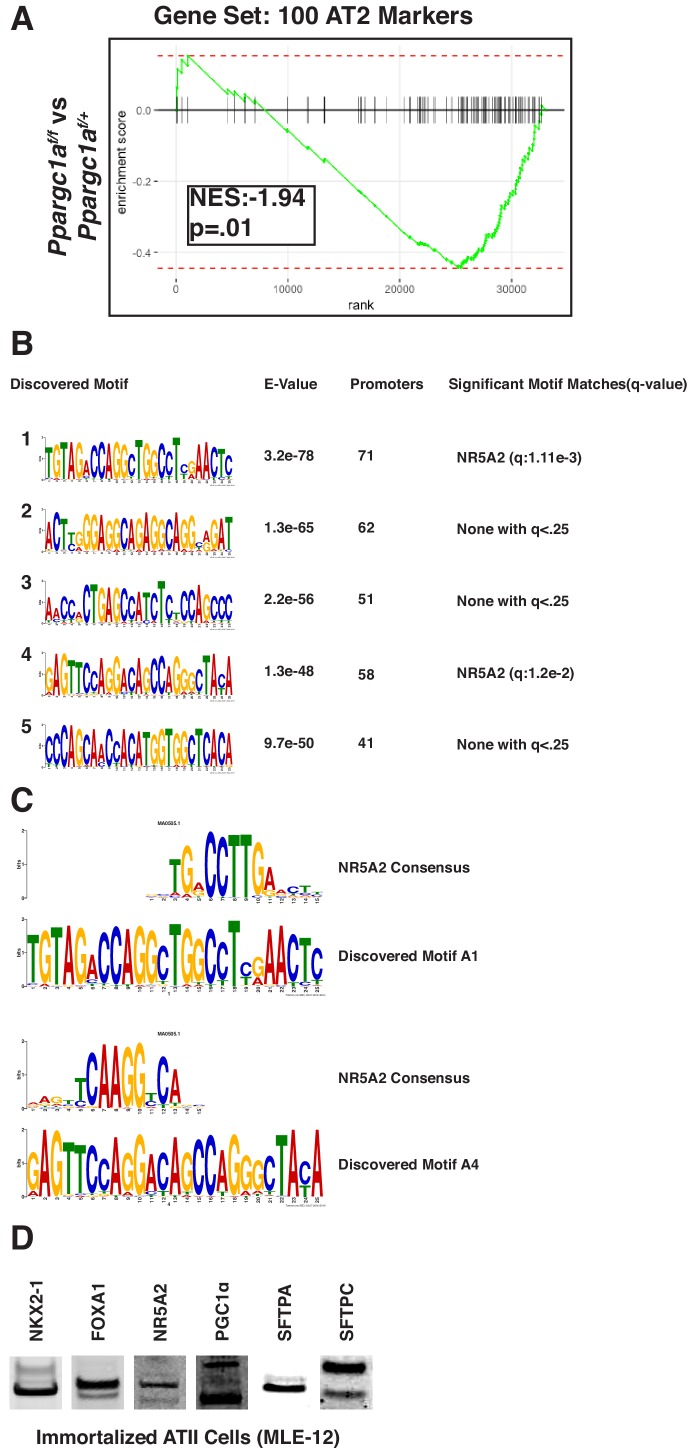
PGC1α is required for maintenance of lung identity in BRAFV600E driven tumors.(A) GSEA mountain plot comparing BRAFV600E/PGC1αNULL driven tumors to BRAFV600E/PGC1αHET driven tumors indicates that reduced PGC1α expression results in a widespread decrease in markers of AT2 pneumocyte identity, P is enrichment statistic. (B) Western blot showing expression of NKX2-1, FOXA1, NR5A2, PGC1α, SFTPA, and SFTPC in the immortalized AT2 cell line, MLE-12.